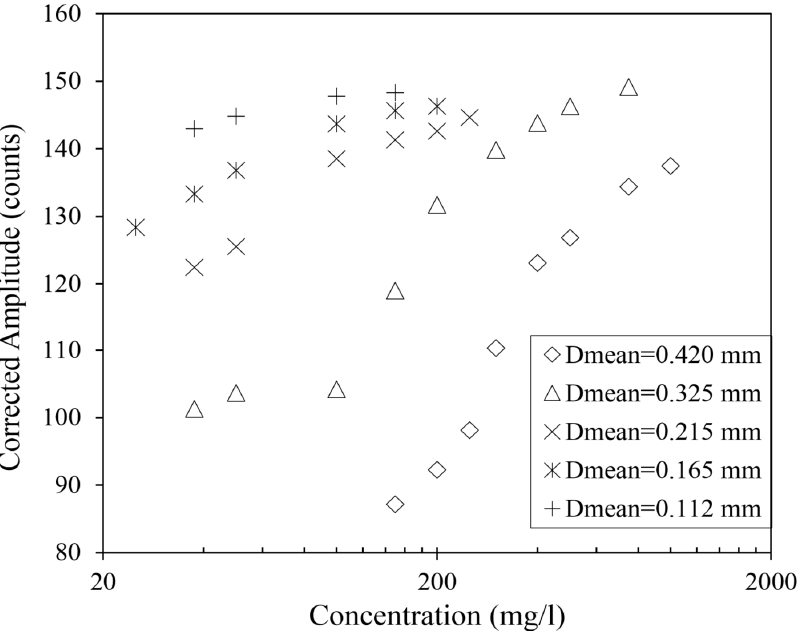
Figure 5. Corrected mean backscattered amplitudes vs. suspended sediment concentration for each sieved fraction.